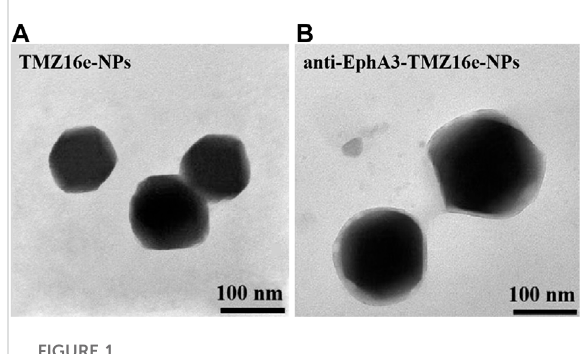
FIGURE 1 Transmission electron microscope images of (A) TMZ16e- NPs and (B) anti-EphA3-TMZ16e-NPs.